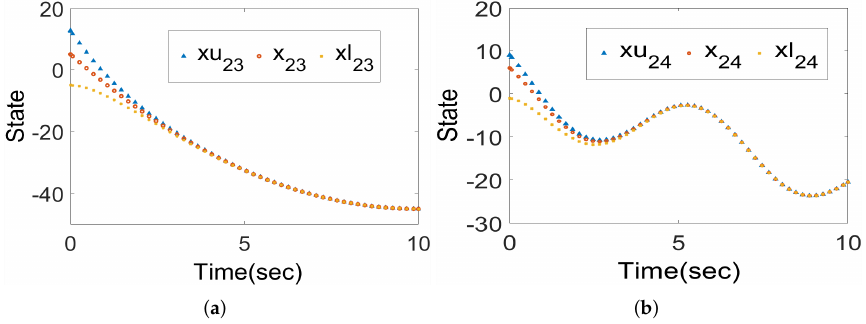
Figure 2. Evolutions of velocity of original system and DIO at the first joint ( a ) and second joint ( b ) of second